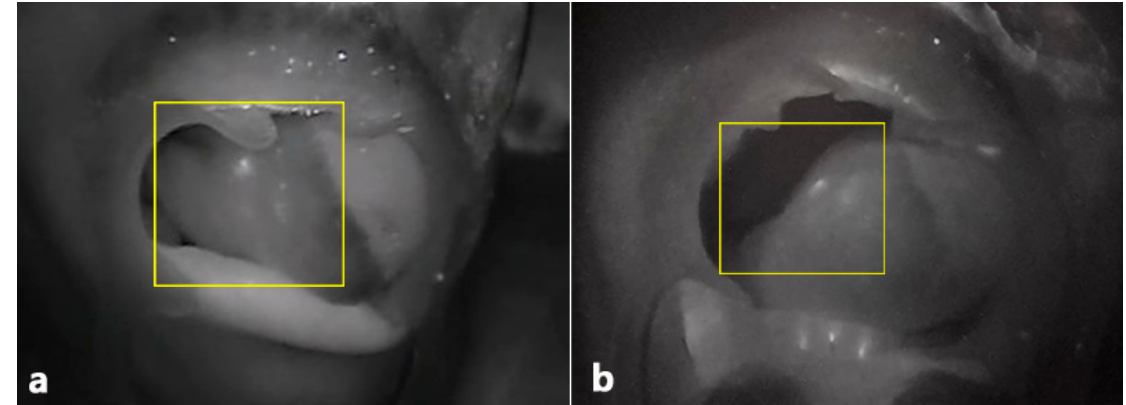
Figure 5. ICG-NIRF image of transferred flap. ( a ) Post-operative ICG-NIRF imaging with Fluobeam ® , ( b ) post-operative ICG-NIRF imaging with the